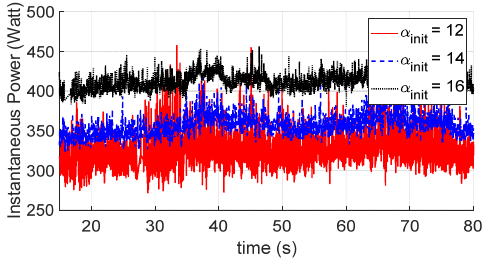
Figure 17. Waypoint mission tracking results for the third flight test scenario.